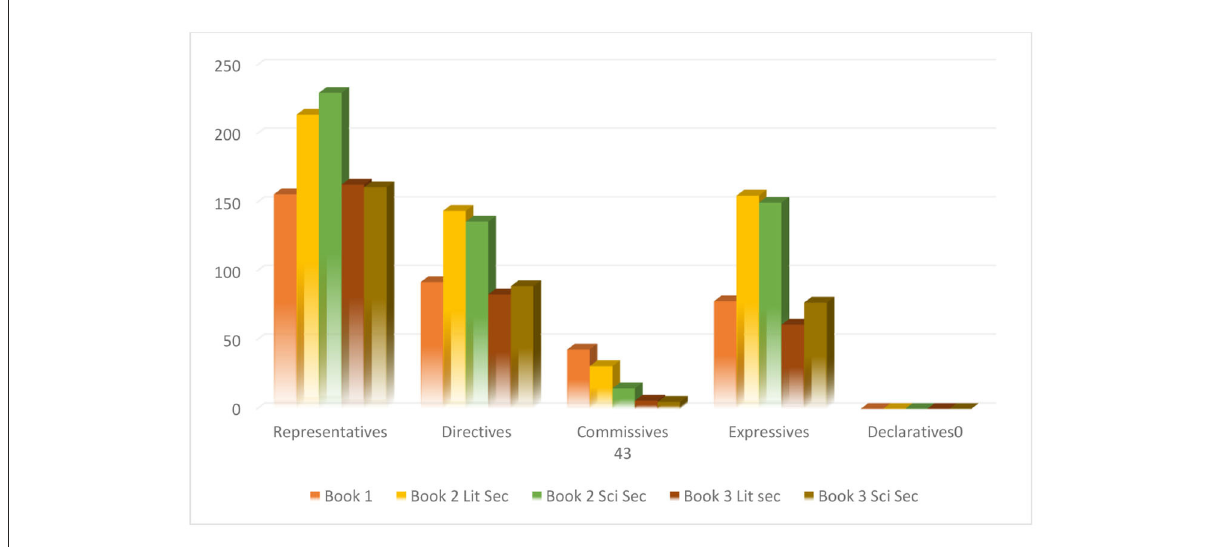
FIGURE1 Overall frequency of speech acts in 21st Century English for Libya secondary 1, 2, and 3 course books and workbooks.